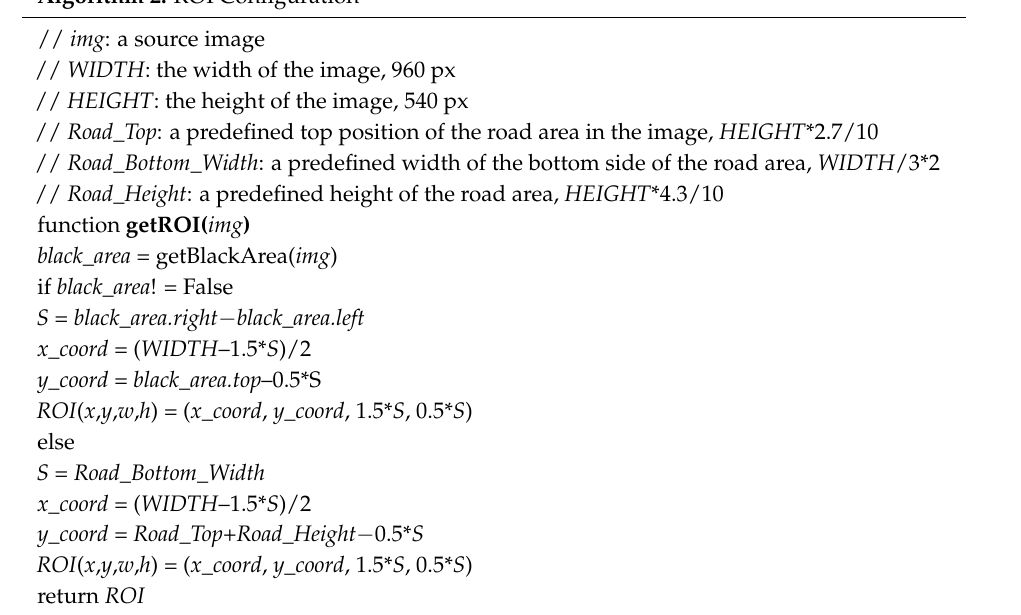
Algorithm 2: ROI Configuration